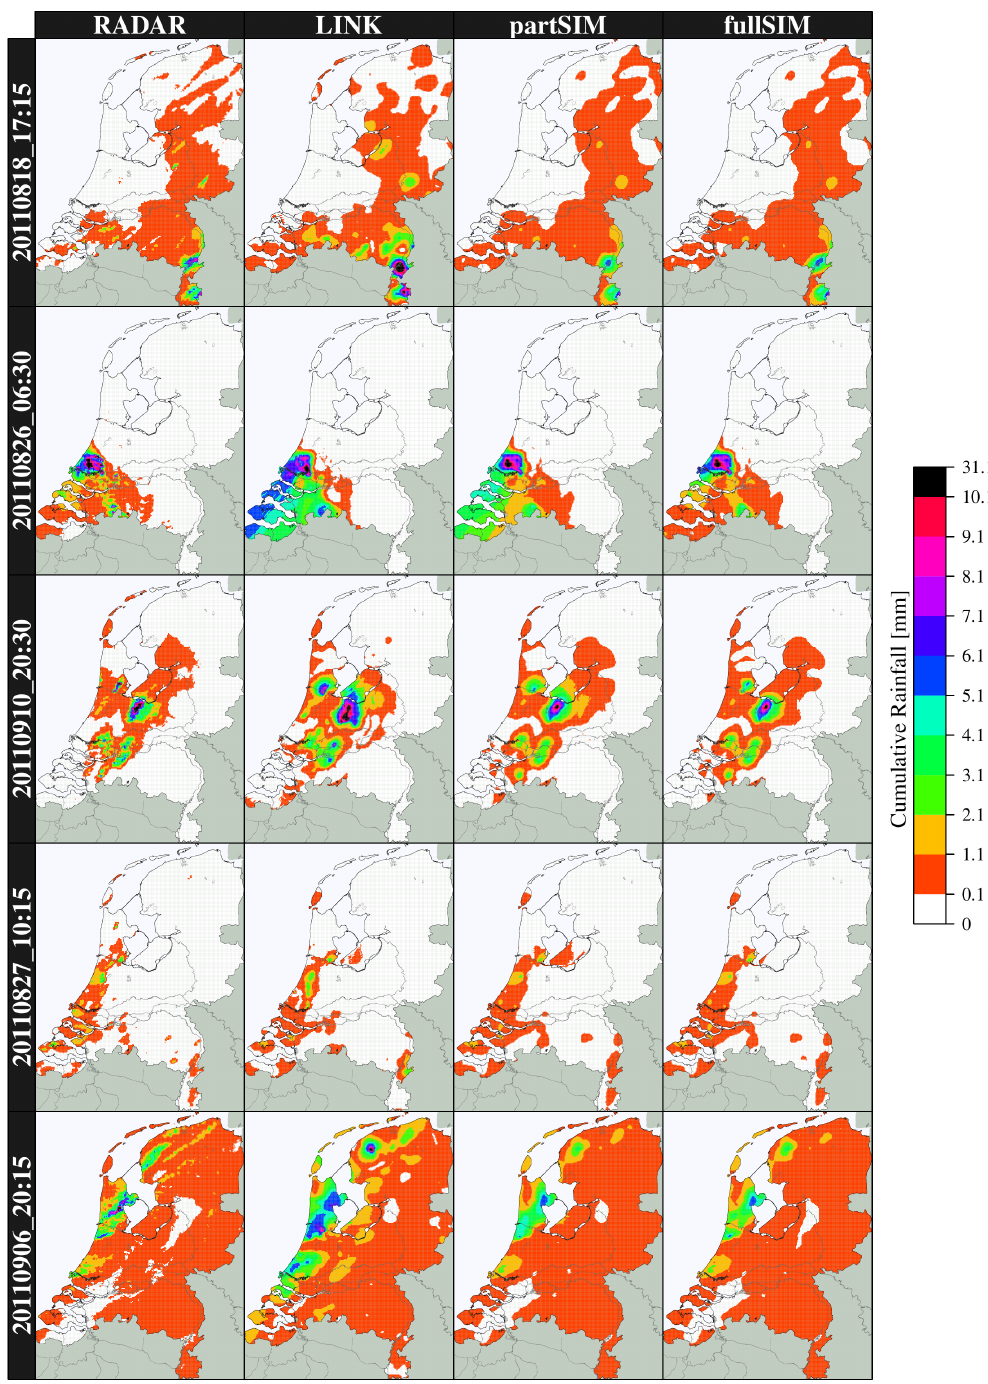
Figure A2. Comparison of 15min interpolated rainfall maps with regard to radar rainfall fields (ground truth, left column). The rows show five of the 1152 time steps (cases) present in the 12-day validation period. The row labels indicate the start UTC for which the maps were